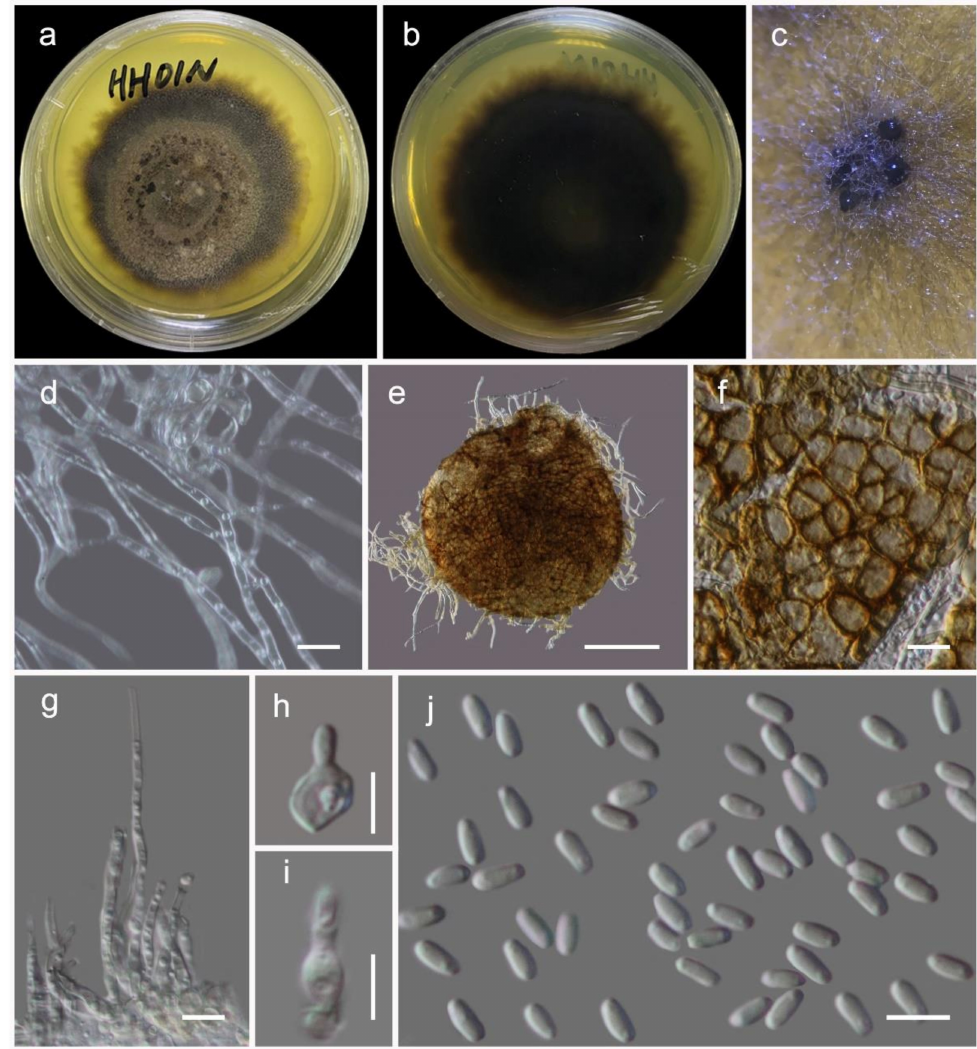
Figure 9. Quixadomyces hongheensis (KUMCC 20-0215, ex-type culture). ( a,b ) colony on PDA ( b from the bottom); ( c ) pycnidia on PDA; ( d ) mycelia; ( e ) squashed pycnidia; ( f ) pycnidia wall; ( g ) paraphy- ses; ( h,i ) conidiophore; ( j ) conidia. Scale bars, ( d,f,g ) 10 µ m; ( e ) 200 µ m; ( h – j ) 5 µ